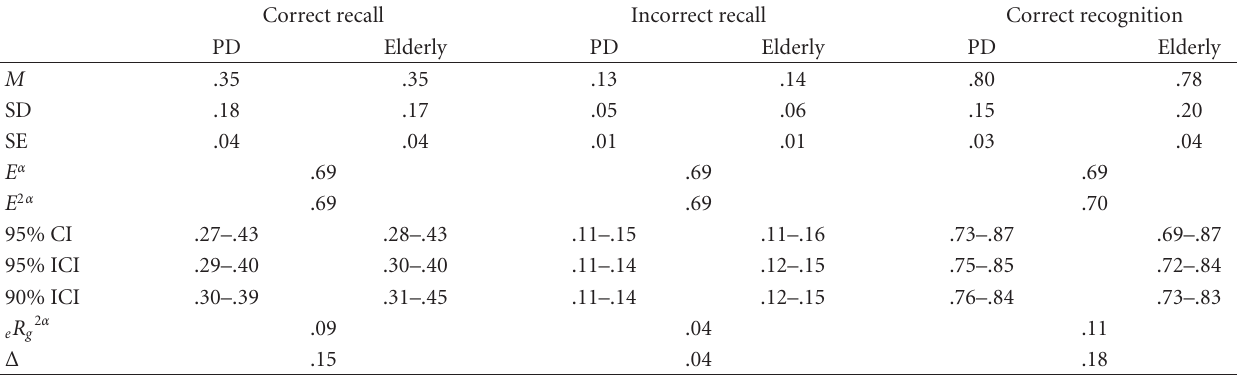
Table 2: Shrinkage factors ( E α and E 2 α ), confidence intervals (CI), inferential confidence intervals (ICI), e R g 2 α , and Δ for memory performance.